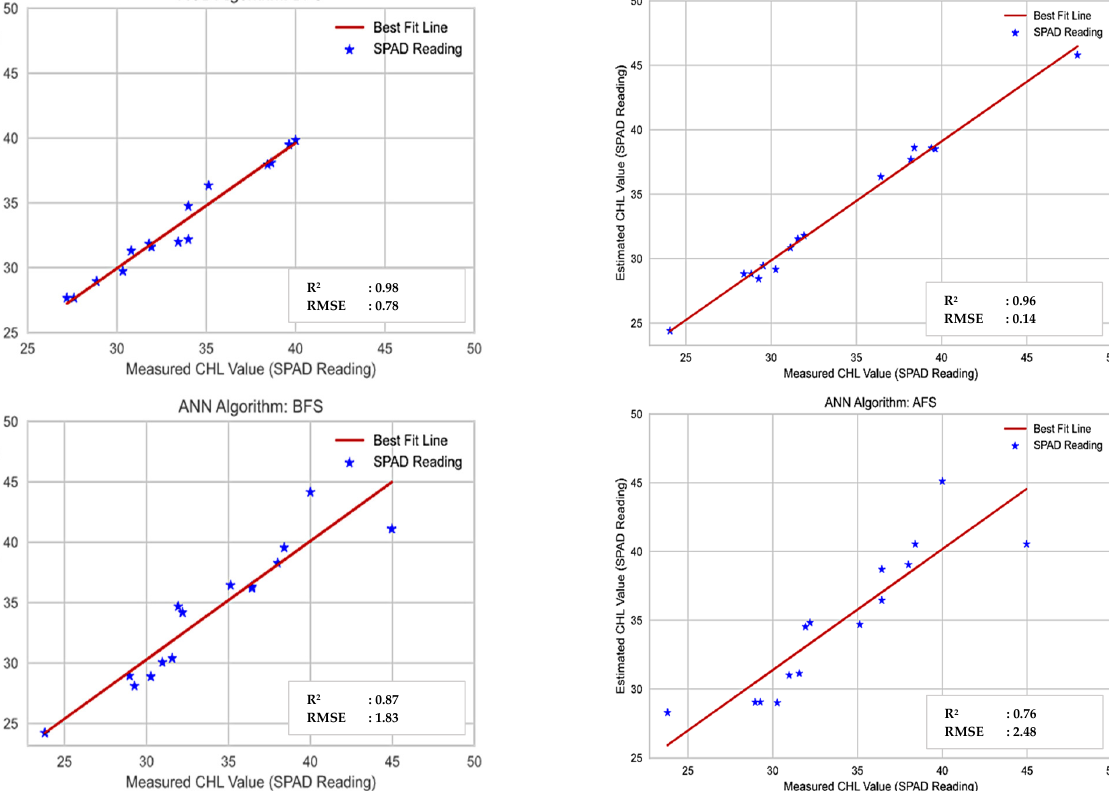
Figure 8. Best fit line of different ML models for left column BFS and right column AFS methods.